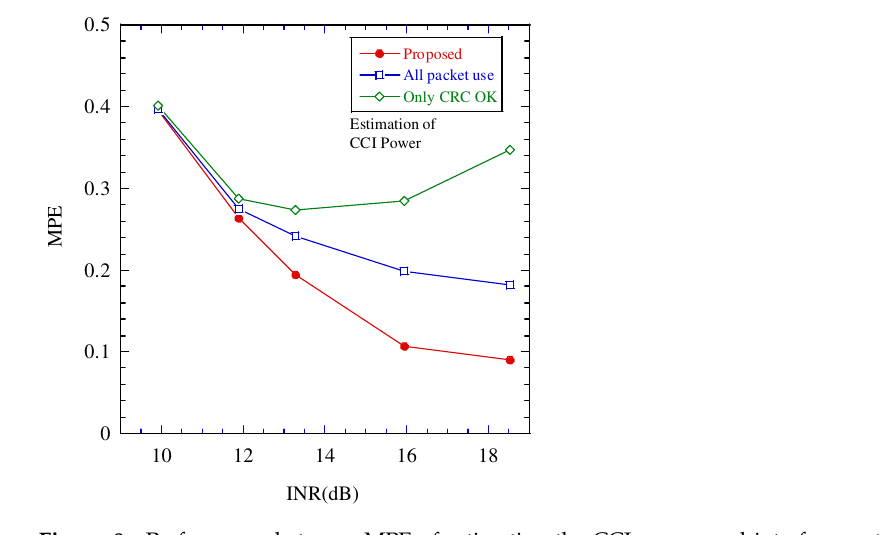
Figure 9. Performance between MPE of estimating the CCI power and interference to noise power ratio (INR).